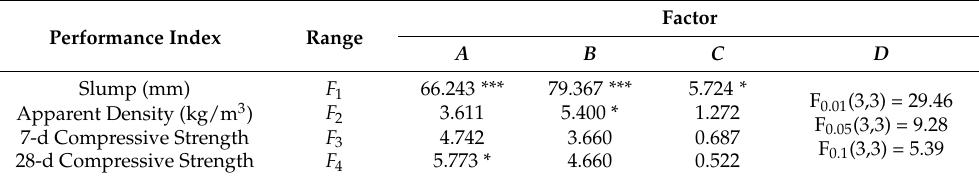
Table 9. The variance